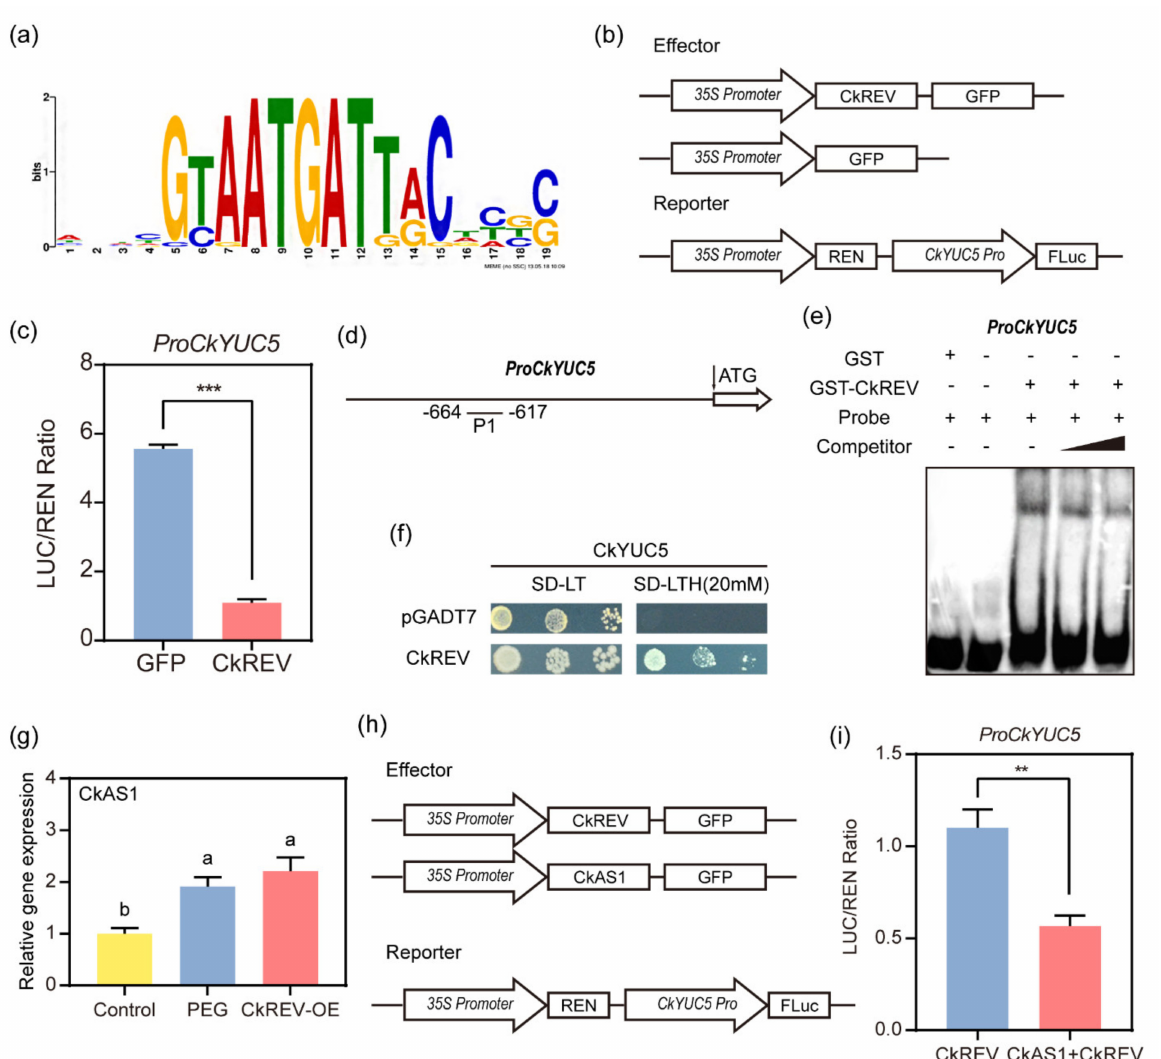
Figure 6. Interaction proof between CkREV and CkYUC5 . ( a ) Recognition site of downstream genes of REV; ( b ) Dual–LUC experimental mode diagram; ( c ) Results of Dual–LUC experiment CkREV interacted with the promoter region of CkYUC5 and negatively regulated its expression compared with GFP control group; ( d ) Sketch map of probe binding site in EMSA experiment; ( e ) Results of EMSA experiment indicated that CkREV–GST could directly bind to ATGAT element in the promoter region of critical enzyme gene CkYUC5 in auxin synthesis; ( f ) The results of yeast one–hybrid further verified the binding of CkREV to the promoter region of CkYUC5 ; ( g ) qRT–PCR detection on CkAS1 expression level in C. korshinskii leaves under different treatments; ( h ) Dual–LUC experimental mode diagram; ( i ) The Dual–LUC experiment was used to detect the effect of CkAS1 as an effector on the regulation of CkREV on CkYUC5. ( c , e , g , i ) Data are shown as the mean ± SD of three independent experiments. ( c , i ) Data are shown as the mean ± SD of three independent experiments. Student’s t –test is employed to measure statistical significance between two samples with a confidence level of 0.95 (**, p < 0.01; ***, p < 0.001). ( g ) Data are shown as the mean ± SD of three independent experiments. One–way ANOVA was performed for the statistical analysis, where different letters represent significant differences ( p <